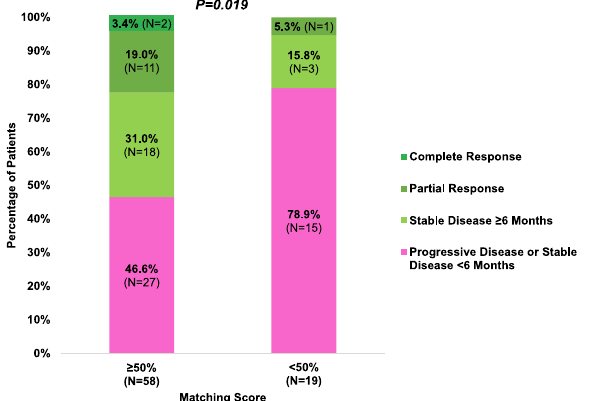
Fig. 3 Clinical bene fi t rate (SD ≥ 6 months/PR/CR) based on Matching Score ( N = 77*). Clinical bene fi t rate (SD ≥ 6 months/PR/ CR) was signi fi cantly higher among patients who received therapy with high ( ≥ 50%) Matching Score (31/58 (53.4%)) when compared to patients with low (<50%) Matching Score (4/19 (21.1%)) ( p = 0.019, univariate analysis). *Three of 80 patients were not evaluable for response since these patients had ongoing SD that was less than 6 months at the time of data cutoff. Abbreviations: CR complete response; PR partial response; SD stable disease. Table 3. Association between patient and treatment characteristics and clinical bene fi t rate (SD ≥ 6 months/PR/CR) ( N = 77 a ).